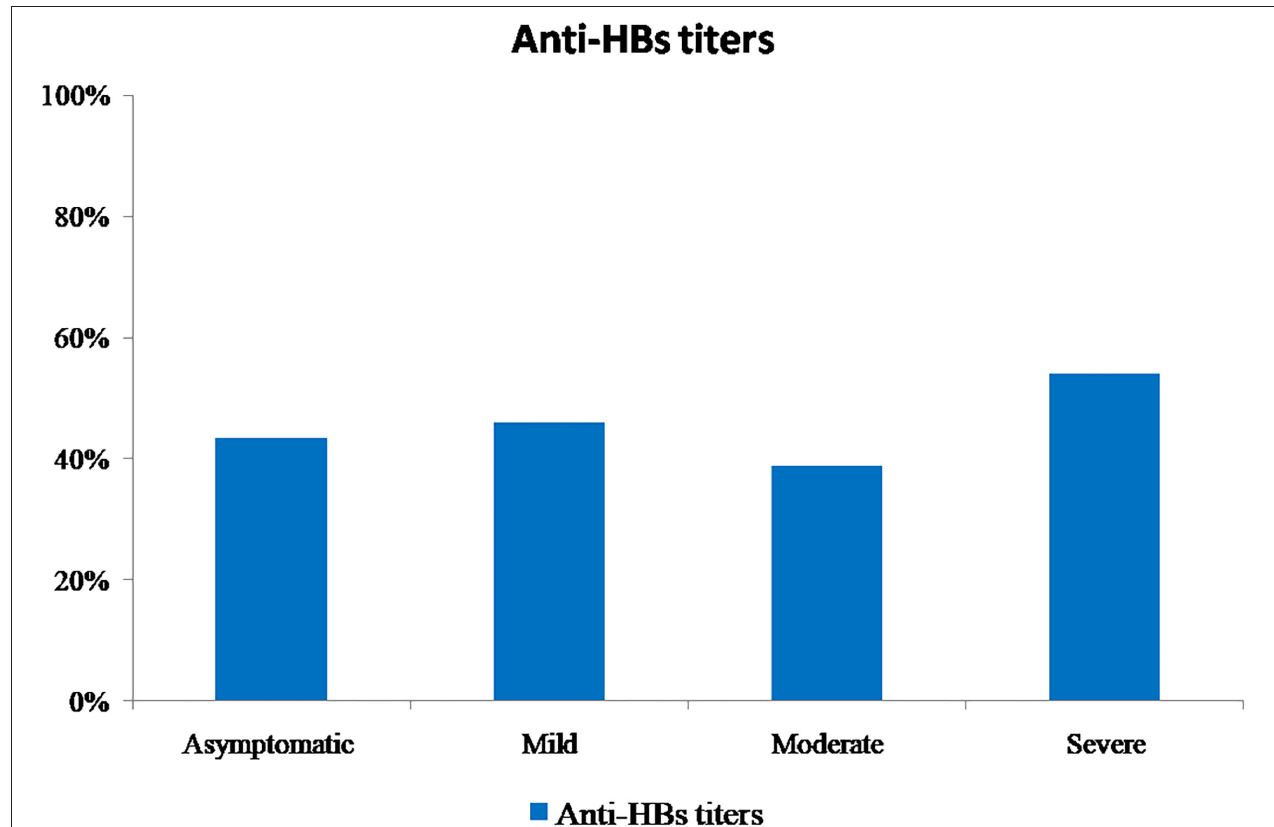
FIGURE 3 | Proportions of Hepatitis B sero-positive patients per COVID-19 severity